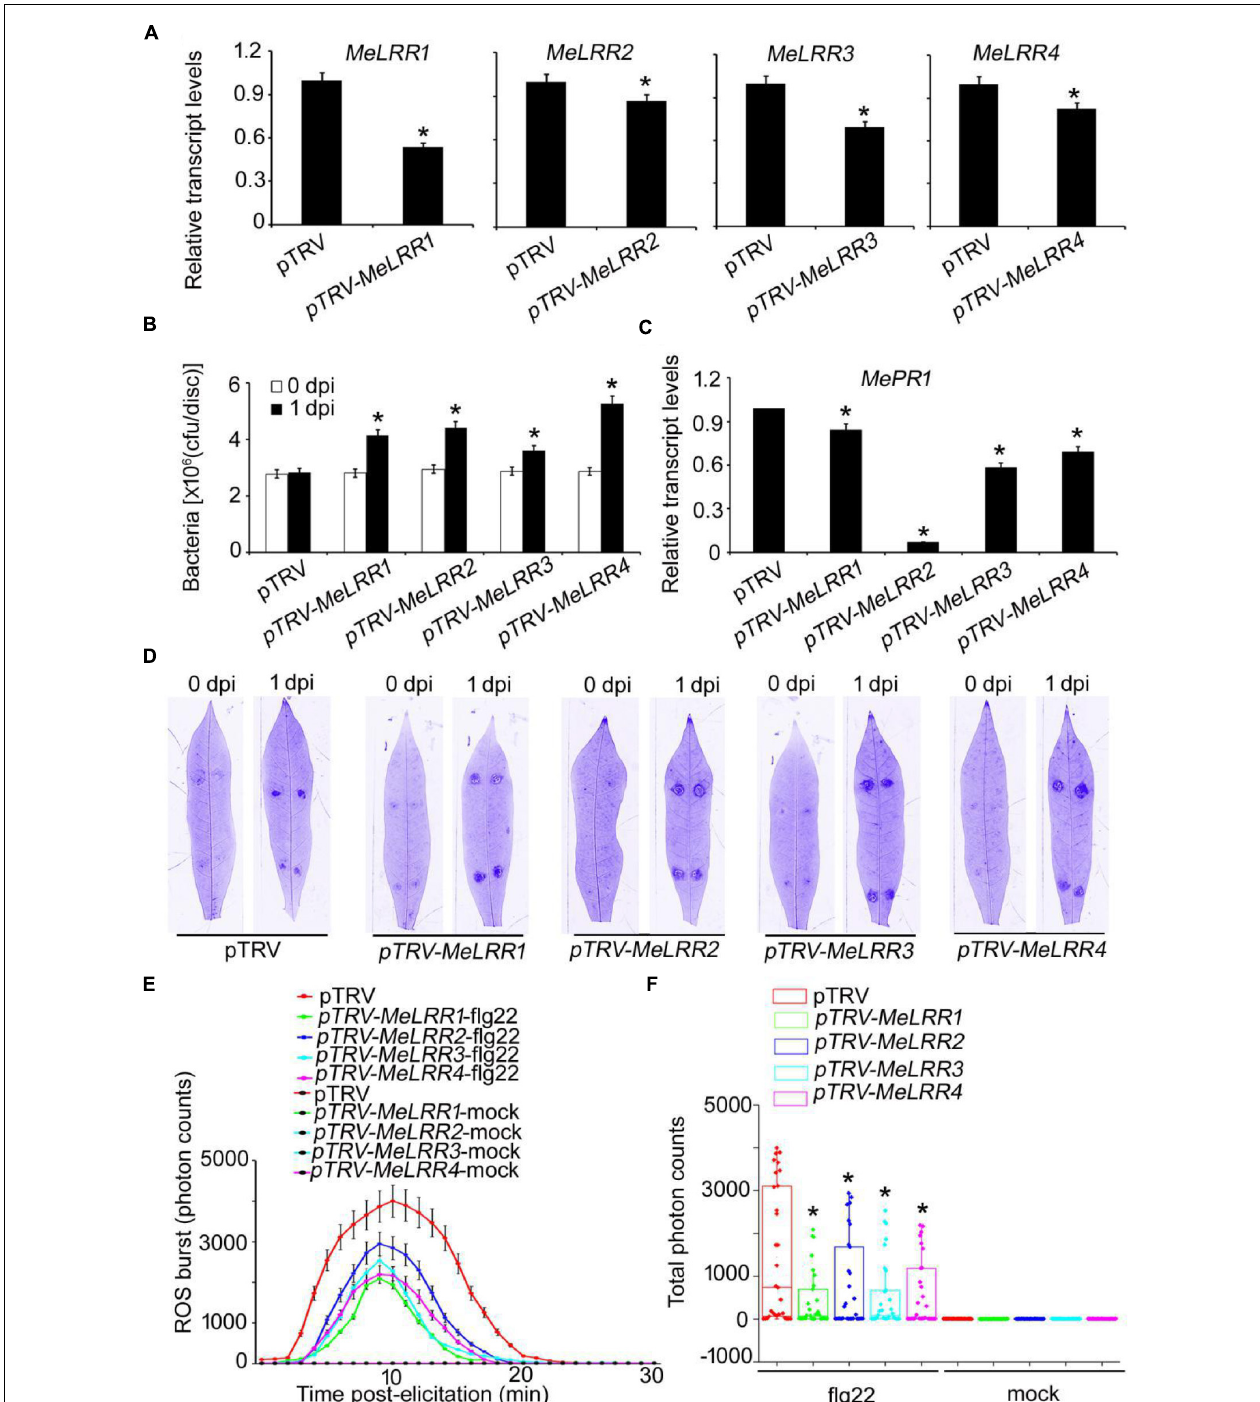
FIGURE 3 | The VIGS of MeLRRs reduced disease resistance against cassava bacterial blight. (A) At 14 dpi, the new leaves were used for relative transcript levels of MeLRRs in MeLRR -silenced leaves and the pTRV control leaves. Then, the new leaves were syringe infiltrated with 4 × 10 8 cfu/mL of pathogenic bacteria Xam used for disease resistance assay. (B) The number of Xam populations in MeLRR- silenced cassava and the pTRV control leaves at 0 and 1 dpi, respectively. (C) The pathogenesis-related gene ( MePR1 ) transcript level was quantitatively analyzed by qRT-PCR at 1 dpi. The relative transcript level of MePR1 in the pTRV control leaves was normalized to 1.0. (D) Cassava leaves were observed using a Coomassie brilliant blue imaging system Fusion FX7-826 apparatus (Vilber Lourmat, France). (E) Dynamic of ROS accumulation in response to flg22 elicitation in MeLRR- silenced cassava and the pTRV control leaves. The flg22-triggered ROS burst were measured using luminol-based assay by a GloMax 96 Microplate Luminometer. (F) Total photon of MeLRR- silenced cassava and the pTRV control leaves. Multiple comparisons of total photon were calculated by Student’s t -test. Asterisks (*) indicate significant differences at p < 0.05. dpi is days post-infection.